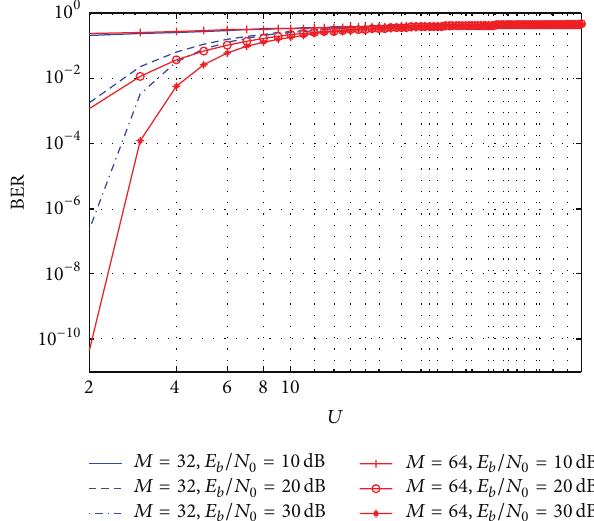
Figure 6: BER performance versus different total number of users.